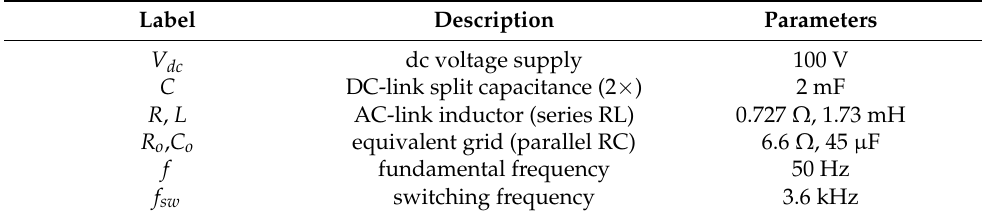
Table 1. Main system parameters.